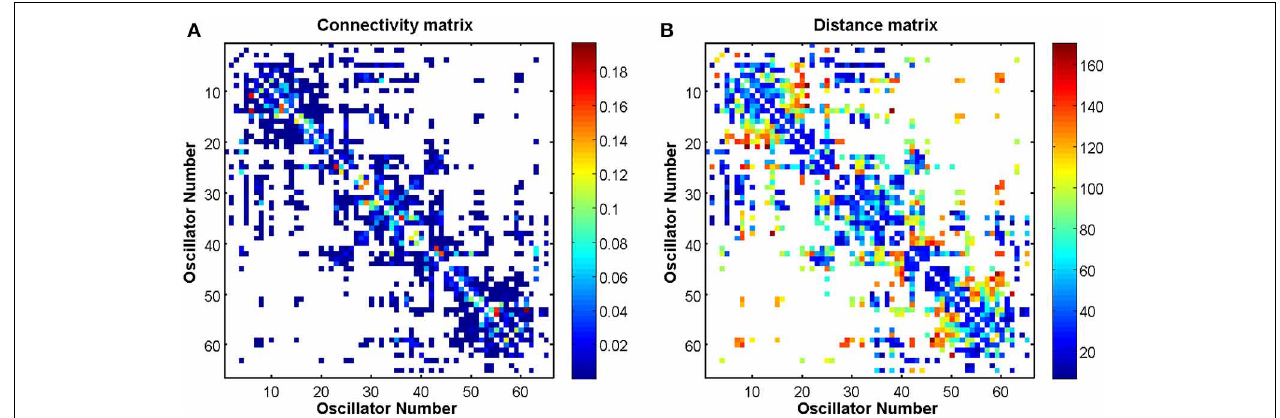
FIGURE 12 | Connectivity and distance matrices for the Cabral model. Each oscillator number represents a brain region, which is defined in Table A1 in the Appendix. An empty (white) element means that the two regions are not connected. Regions are not connected to themselves so that the diagonals are white. (A) Shows the pairwise connection matrix C between the 66 oscillators. (B) Shows the matrix